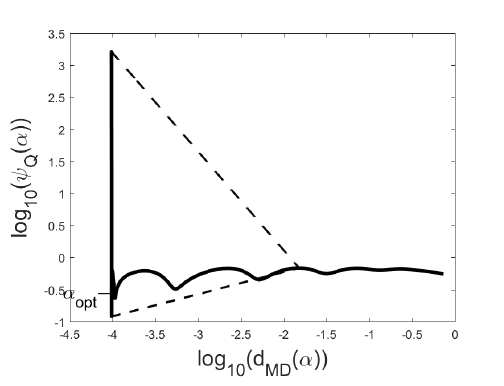
Figure 6. Q-curve in Spikes.